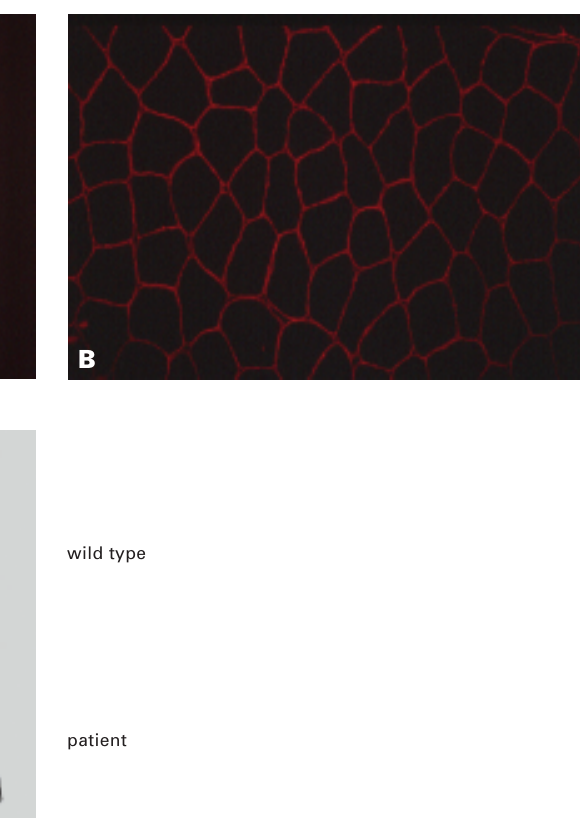
Figure 2 Electropherograms showing part of exon 2 of the a -sarcoglycan gene. Upper panel: wild-type sequence. Lower panel: patient’s sequence containing the novel homozygous mutation c.86dupA